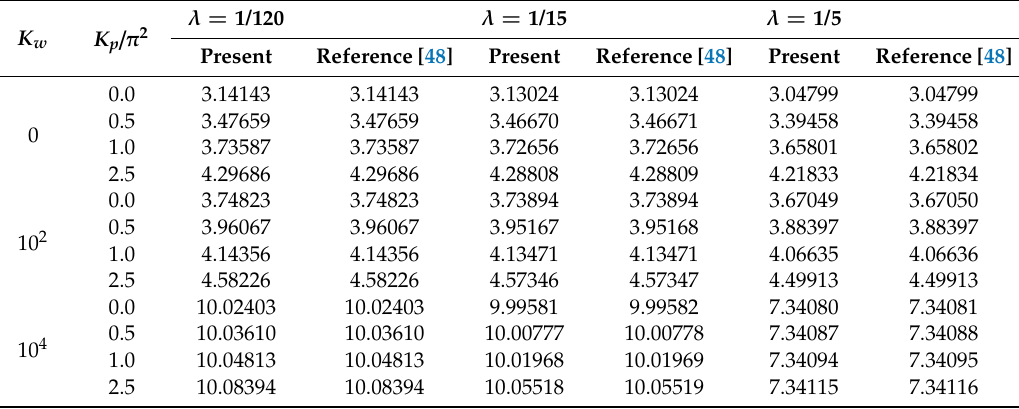
Table 1. Comparisons of the fundamental frequency parameter (cid:36) of an isotropic homogeneous beam on elastic foundations.